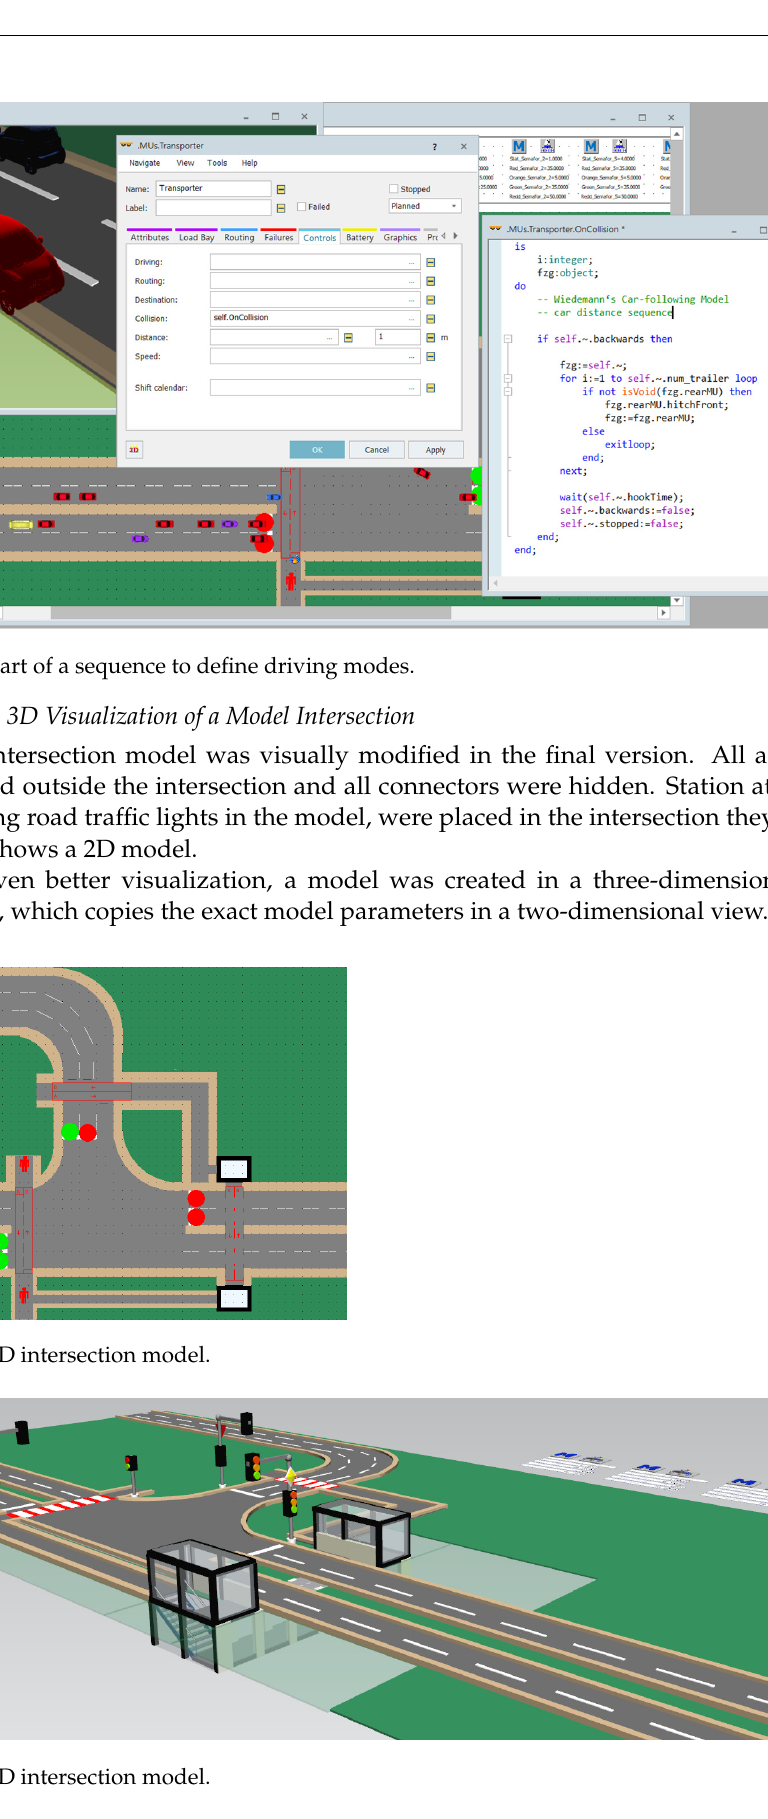
Figure 15. 3D intersection